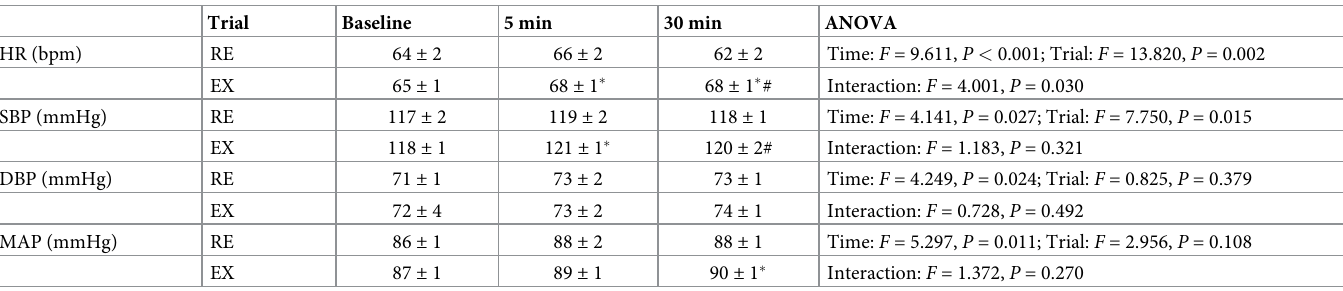
Table 2. Time-course changes in hemodynamic